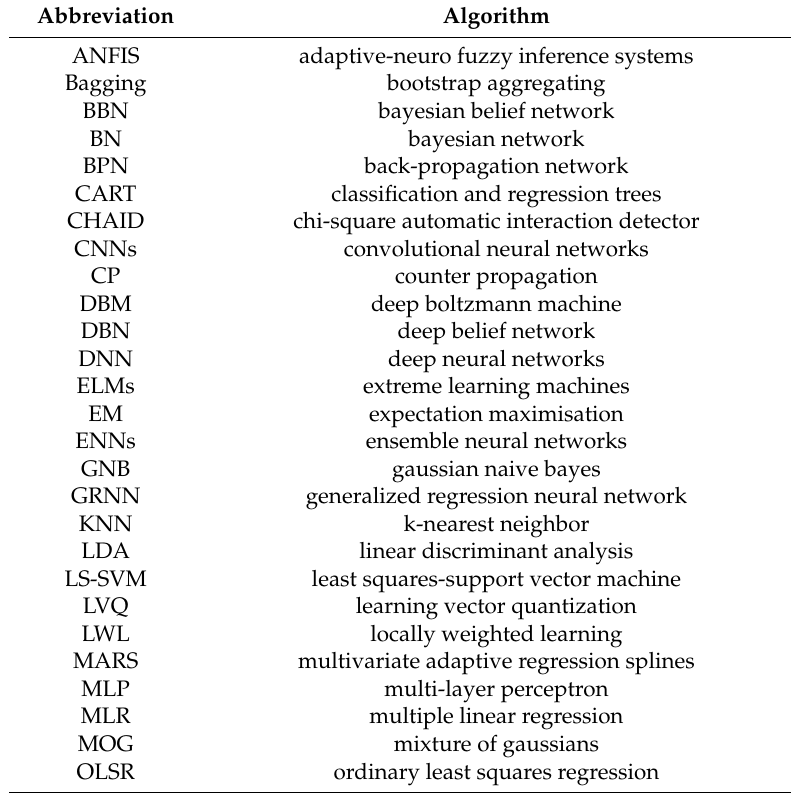
Table 2. Abbreviations for machine learning